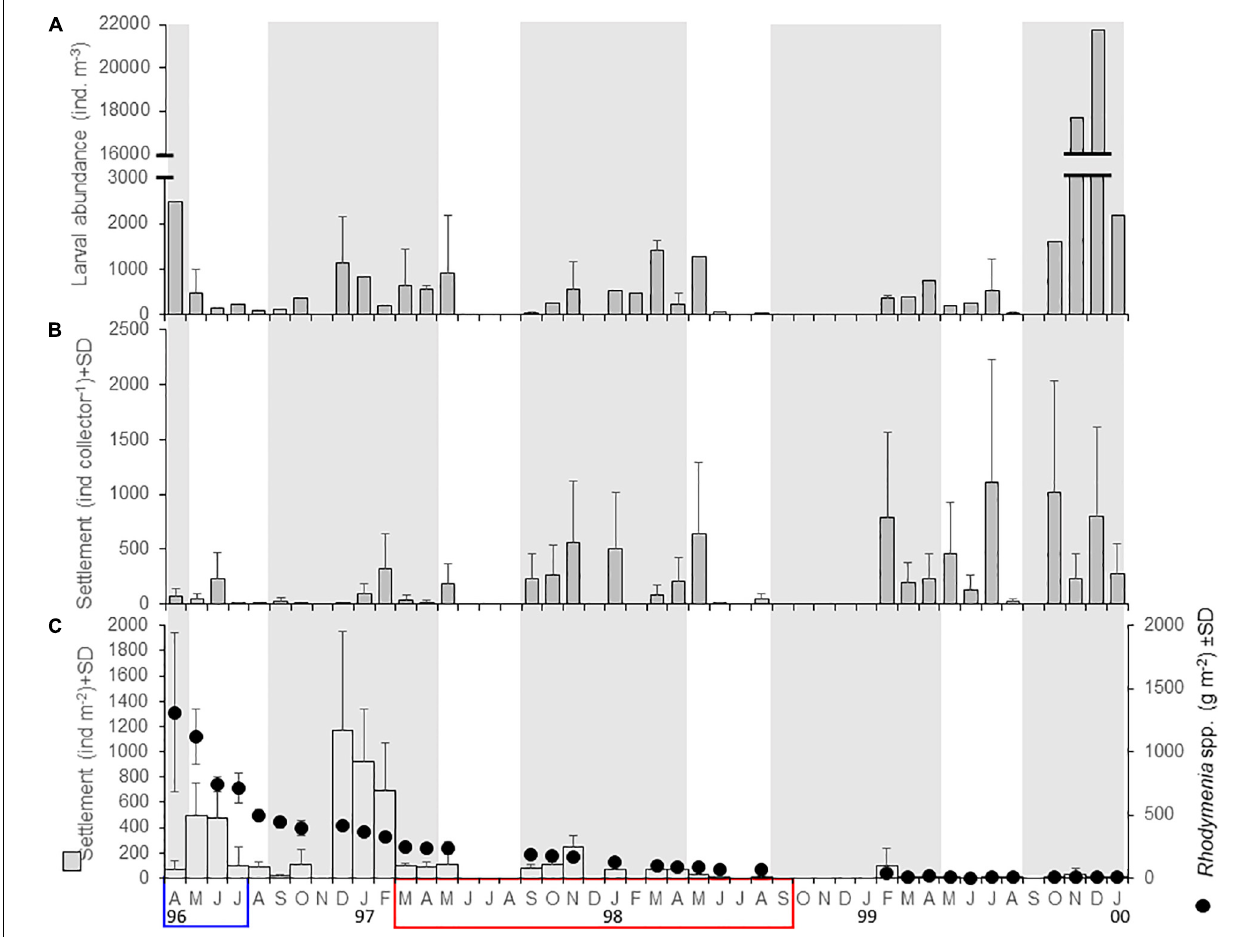
FIGURE 5 | Temporal variability of population processes during the larval stage and settlement of Argopecten purpuratus in La Rinconada Marine Reserve between April 1996 and January 2000. (A) Abundance of larvae in the water column; (B) larval settlement in artificial collectors, and (C) larval settlement in the seaweed Rhodymenia spp. Blue and red panels indicate the occurrence of La Niña and El Niño episodes, respectively, according to El Niño Coastal Index (see Figure 3 ). Gray panels in the background denote periods of spawning activity after Cantillánez et al.